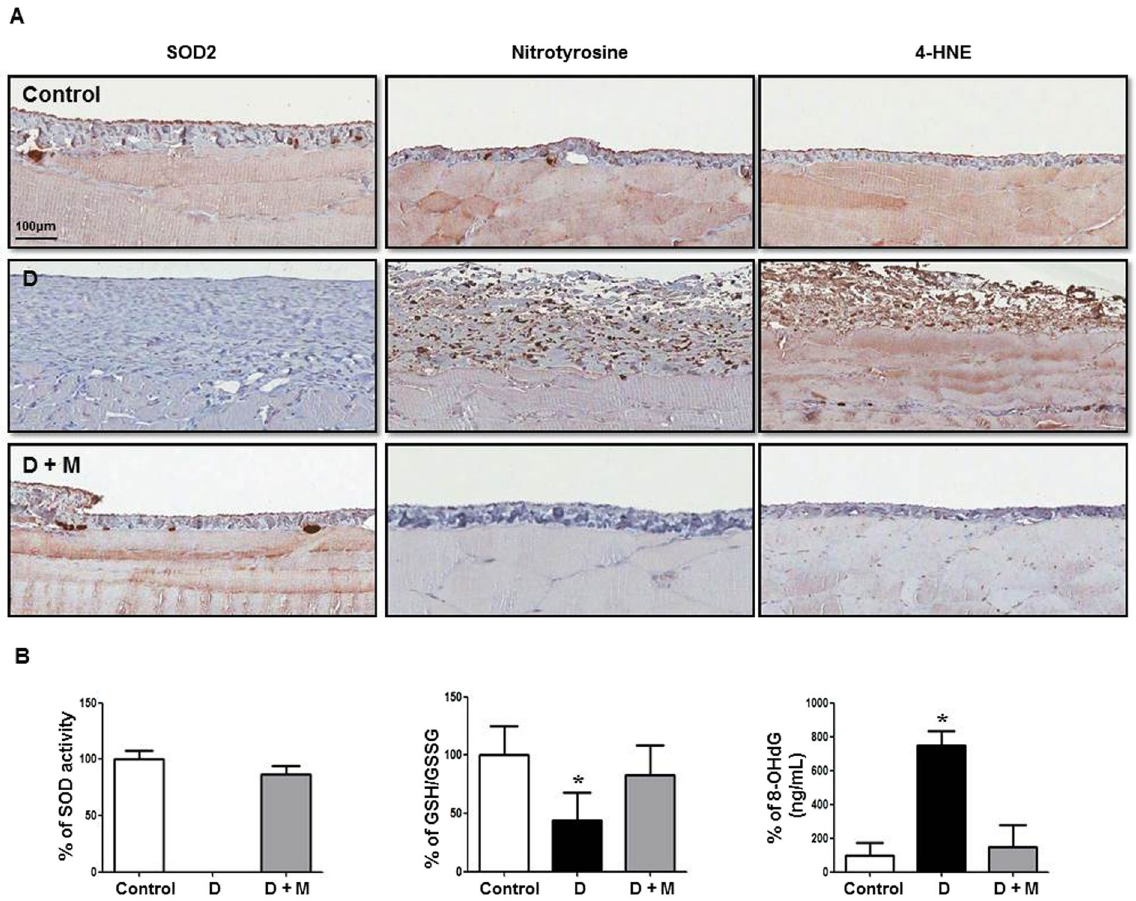
Figure 10. Effect of Metformin on Intraperitoneal Oxidative Stress in Animal Model of Peritoneal Dialysis. ( A ) In dialysis group (D), a decrease in superoxide dismutase 2 (SOD2) with an increased staining of nitrotyrosine (NT) and 4-hydroxynonenal (4-HNE) in peritoneal membrane is observed. Rats in group D + M demonstrates an alleviation of altered expression of SOD2, NT and 4-HNE. ( B ) SOD activity and GSH/GSSG in peritoneal effluent are significantly decreased in group D with an increase in 8-OH-dG, which are ameliorated in group D + M. Representative immunohistochemical staining of parietal peritoneum is shown ( A ) Magnification × 200. N = 4. * p < 0.05 vs.